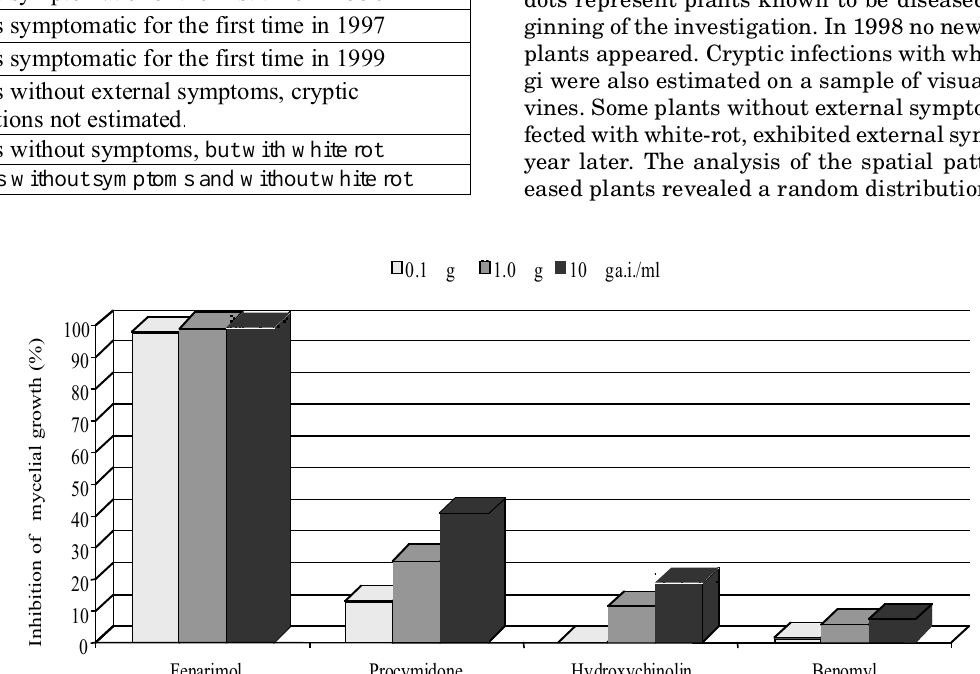
Fig. 8. Control of S. hirsutum in vitro . Inhibition of radial growth by fungicides is expressed as the mean percent of three experiments. The fungicides were tested at three different concentrations (0.1, 1.0 and 10 m g a.i. / ml). The most effective fungicide for inhibiting mycelial growth was the EBI fungicide fenarimol.